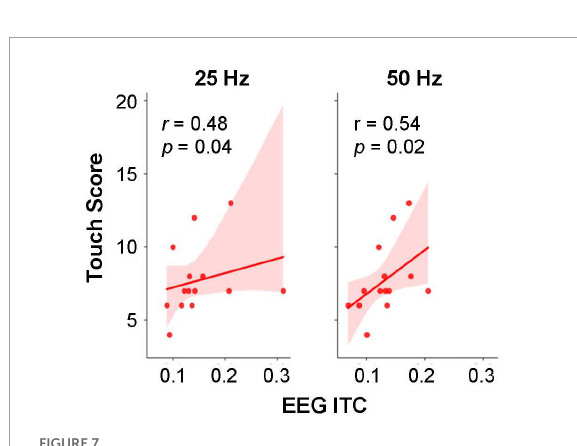
FIGURE7 Relationship between EEG ITC values at 25 and 50 Hz and the Touch Processing–Sensation Avoiding section of the Adult Adolescent Sensory Profile (AASP Som ) for subjects in the ASD group. The p -values for the correlation coefficients ( r ) were computed using Spearman rank-order test, uncorrected. Shading indicates 95% confidence